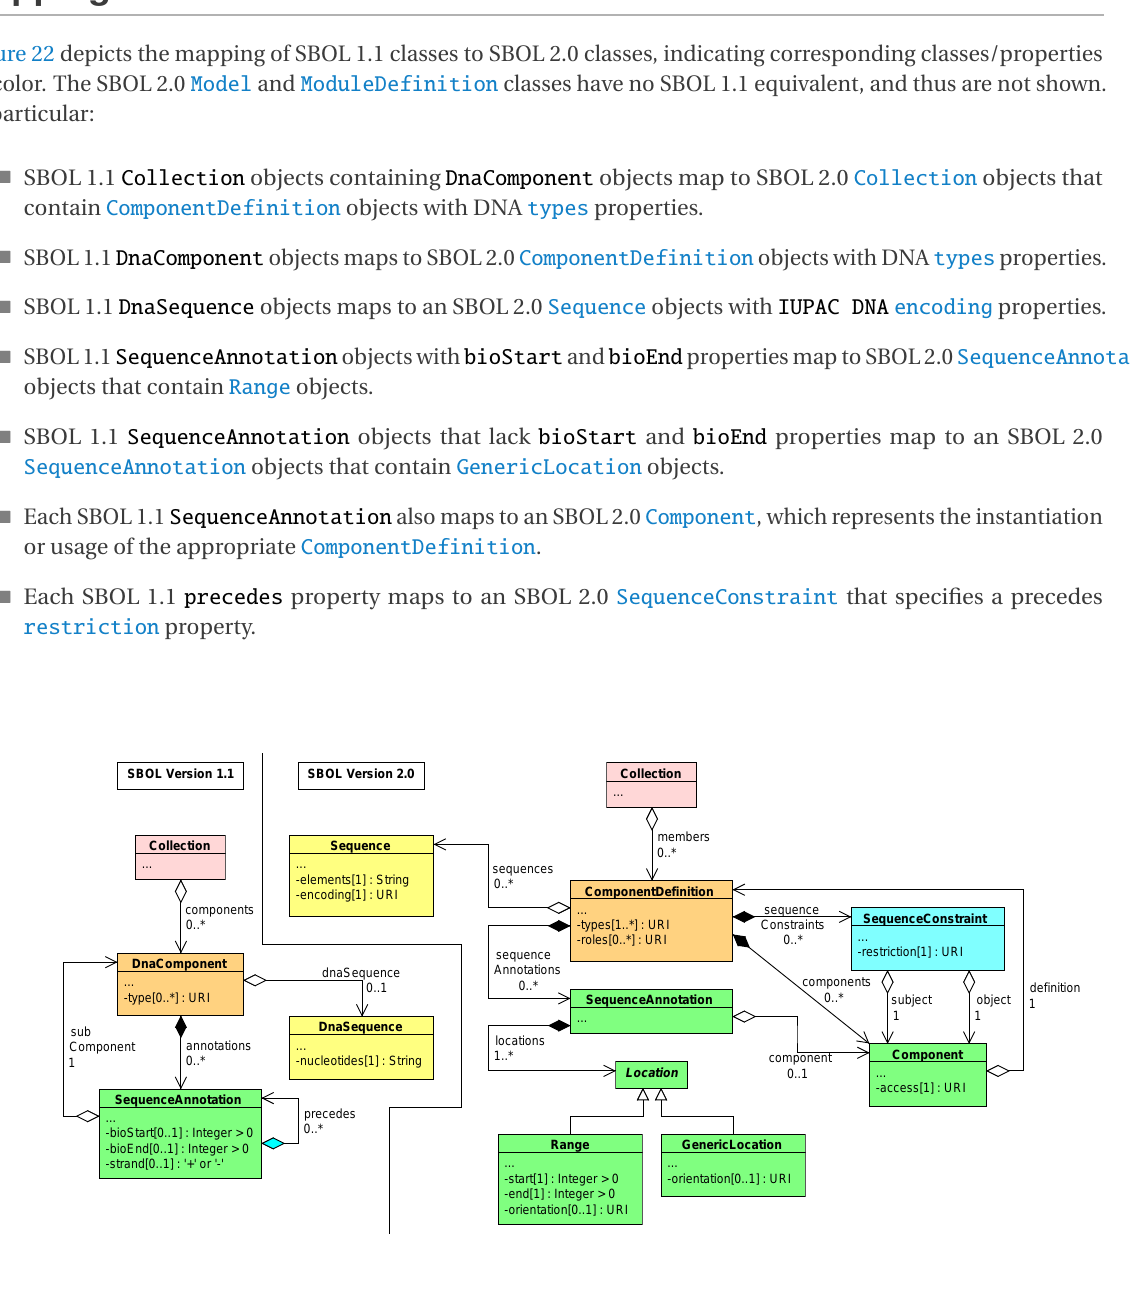
Figure 22 depicts the mapping of SBOL 1.1 classes to SBOL 2.0 classes, indicating corresponding classes/properties